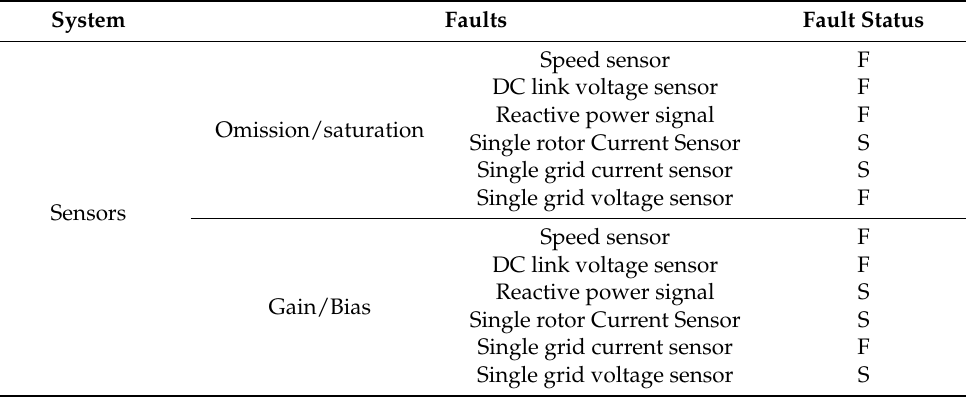
Table 2. Survivability status for sensor faults [13].